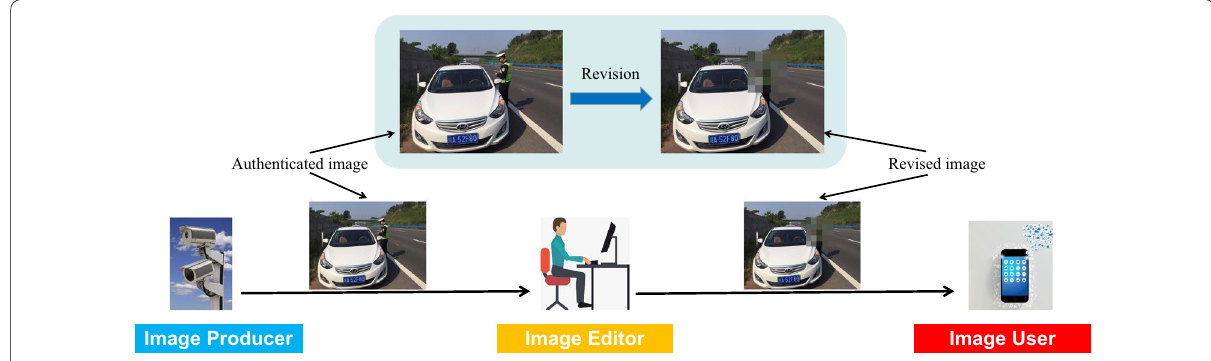
Fig. 1 The workflow of a privacy-aware image authentication